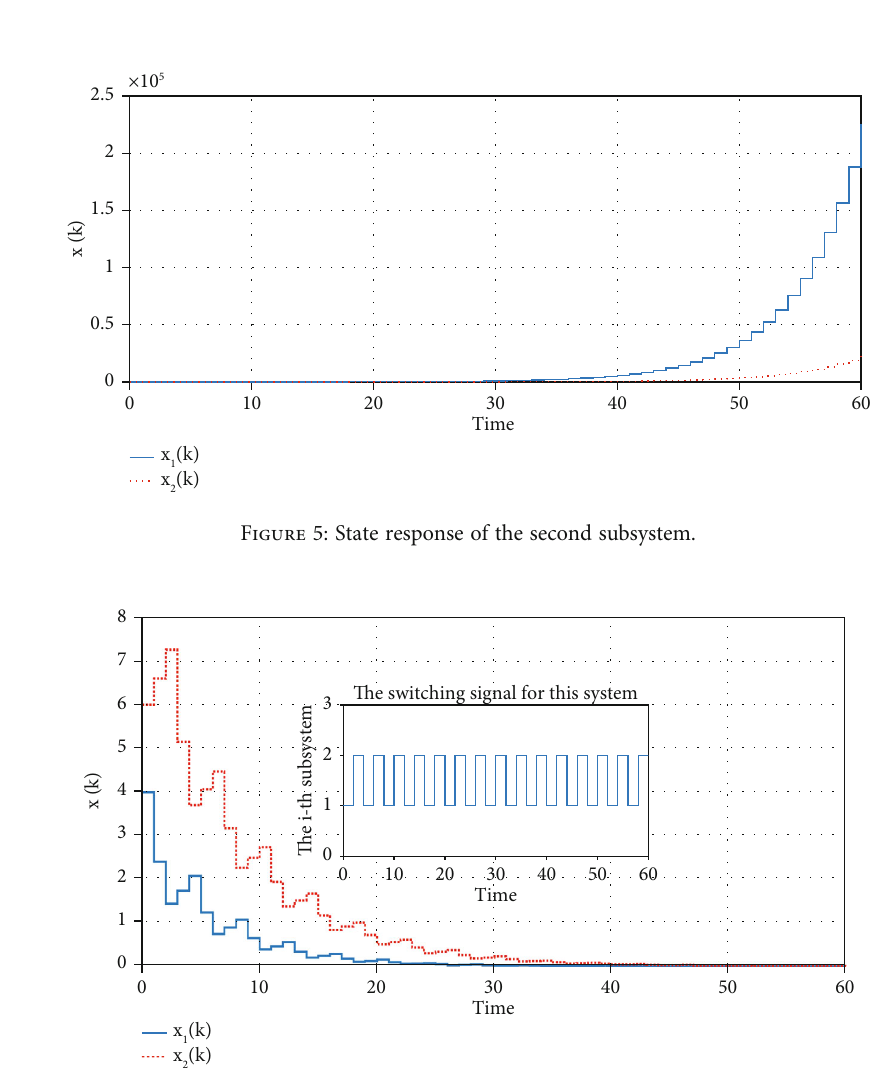
Figure 6: State response of the discrete-time system.